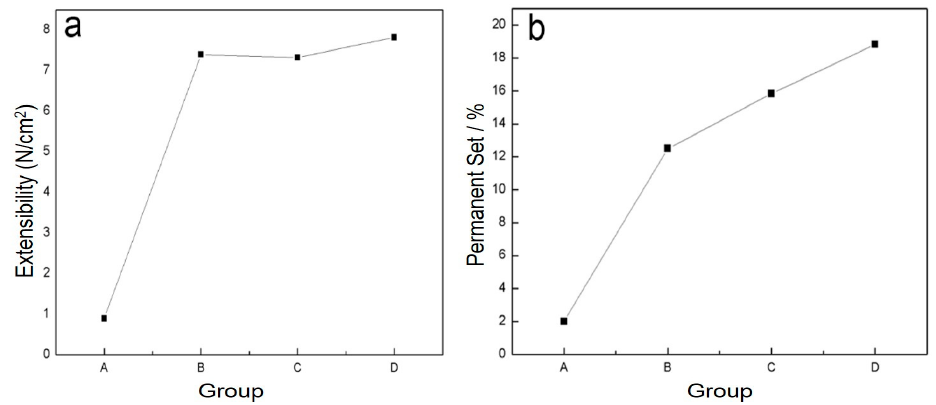
Figure 5. The comfortability of the blends was assigned through extensibility ( a ) and permanent set ( b ).